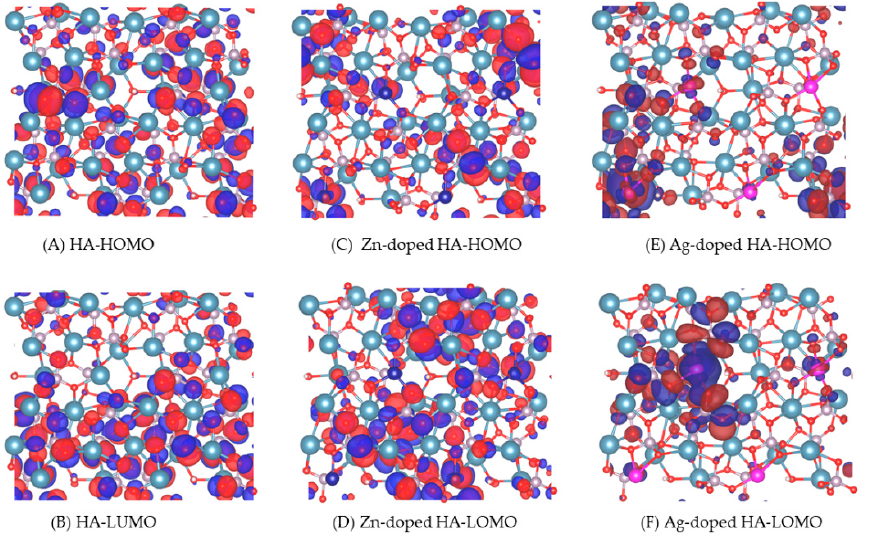
Figure 7. HOMOs and LUMOs of HA, Zn-doped HA, and Ag-doped HA.